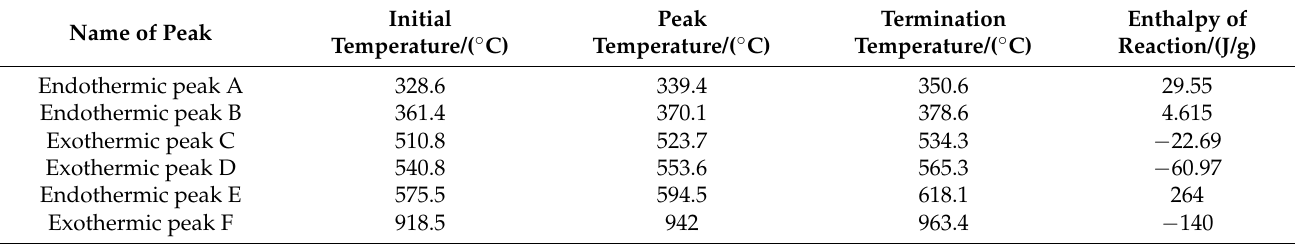
Table 19. The endothermic/exothermic peak parameters of Al-rich Al/PTFE/TiH 2